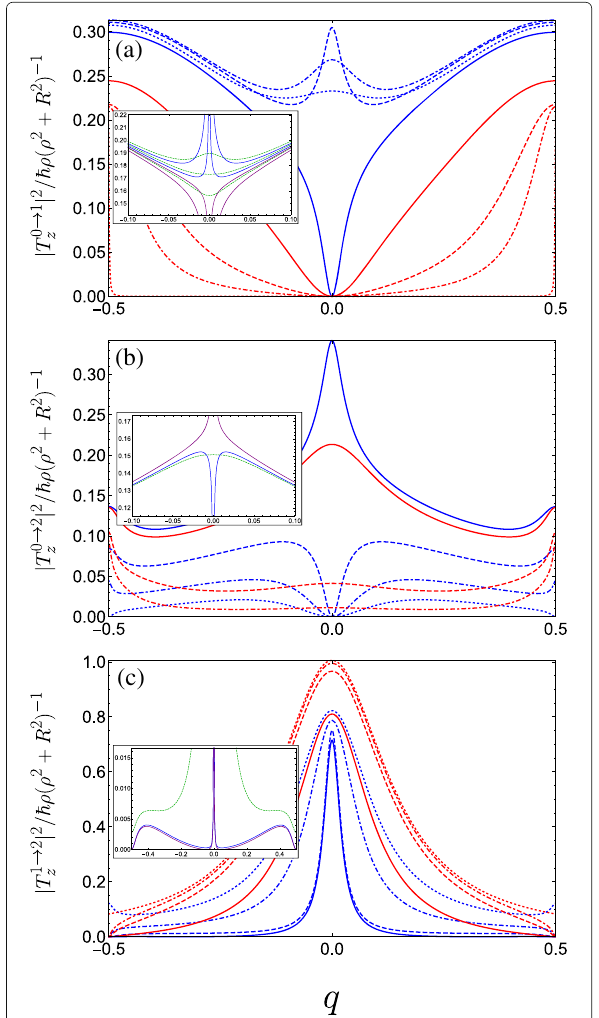
Fig. 5 Square of the dimensionless momentum operator matrix element between the g th and f th subbands in the first Brillouin zone as a function of the dimensionless wave vector q of the electrons photoexcited by linearly z -polarized radiation and for a variety of parameter combinations spanning the first incident of resonance. The different blue curves keep A g = 0.5 and C ⊥ = 0 fixed and vary B g = 0.1, 0.2, and 0.3 corresponding to dot-dashed, dashed, and solid. The different red curves keep B g = 0.3 and C ⊥ = 0 fixed while varying A g = 0.05, 0.1 and 0.3 as dot-dashed, dashed, and solid, while the dotted blue (dotted red) plots the limiting case A g = 0.5 & B g → 0 ( A g → 0 & B g = 0.3). a Transitions between the ground and first bands. The inset plots the behaviour for fixed A g = 0.5 and changing B g crossing the resonant condition at B g = 0.25 (see text) in a reduced q -range, ranging from upper blue B g = 0.245, lower blue B g = 0.249, upper purple B g = 0.251, to lower purple B g = 0.255. The dashed green curves are for small non-zero transverse field C ⊥ = 0.05 ranging from B g = 0.245 (upper curve) to B g = 0.255 (lower curve) in increments of 0.05. b Plots transitions between the ground and second bands, the inset plots the behaviour close to resonance when A g = 0.5; blue is B g = 0.249, purple is B g = 0.251, and dark green is at resonance with C ⊥ = 0.05. c Plots transitions between the first and secondbands,theparametersfortheinsetarethesameasthosein( b )